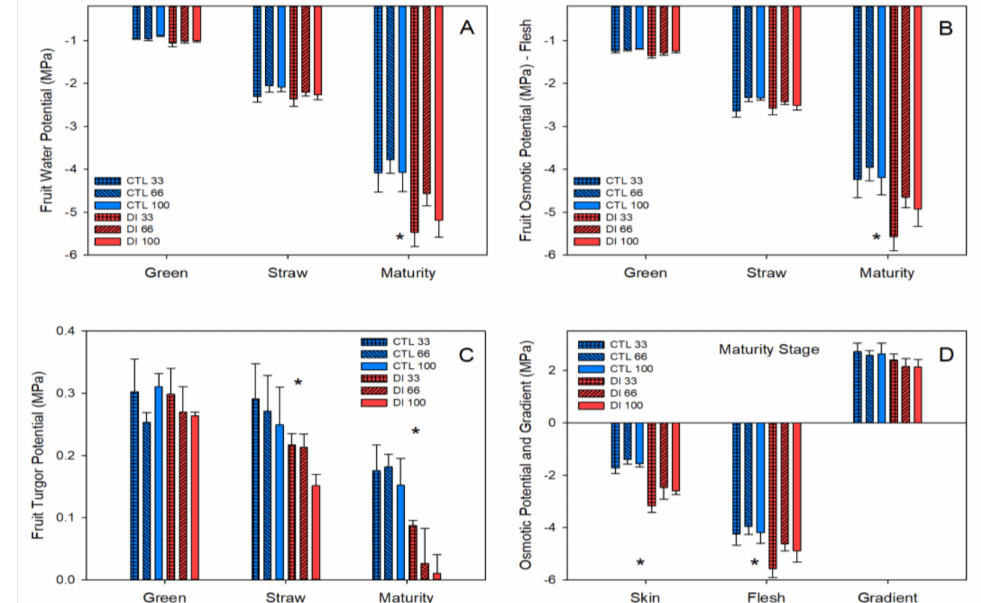
Figure 4. Fruit water potential ( A ), fruit osmotic potential ( B ), fruit turgor potential ( C ), and fruit osmotic potential gradient between skin and flesh at harvest ( D ) for the two irrigation treatments: CTL (full irrigated treatment; blue) and DI (deficit irrigation treatment; red), and the three levels of crop load: low (33%), medium (66%), and high (100%). Each bar is the mean ± SD of six fruits. Asterisks indicate significant differences between CTL and DI, according to ANOVA ( p <